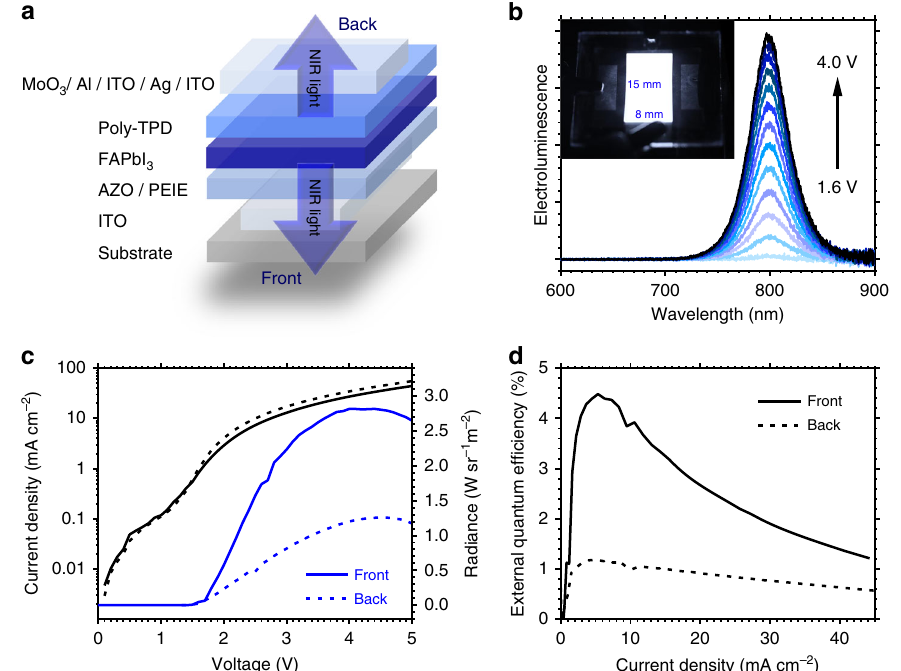
Fig. 1 Architecture and performance of transparent perovskite light-emitting diode. a Device structure of ITO/AZO/PEIE/FAPbI 3 /Poly-TPD/MoO 3 /Al/ ITO/Ag/ITO PeLED. b Electroluminescence spectra of PeLED from 1.6 to 4.0 V. Inset shows the near-infrared photo of a 120-mm 2 PeLED. c Combined current density vs. voltage (black solid and dashed lines) and radiance vs. voltage plots (blue solid and dashed lines) of PeLED. d External quantum ef fi ciency vs. current density plots of PeLED. Solid lines represent device measurements from the front and dashed lines represent measurements from the back.